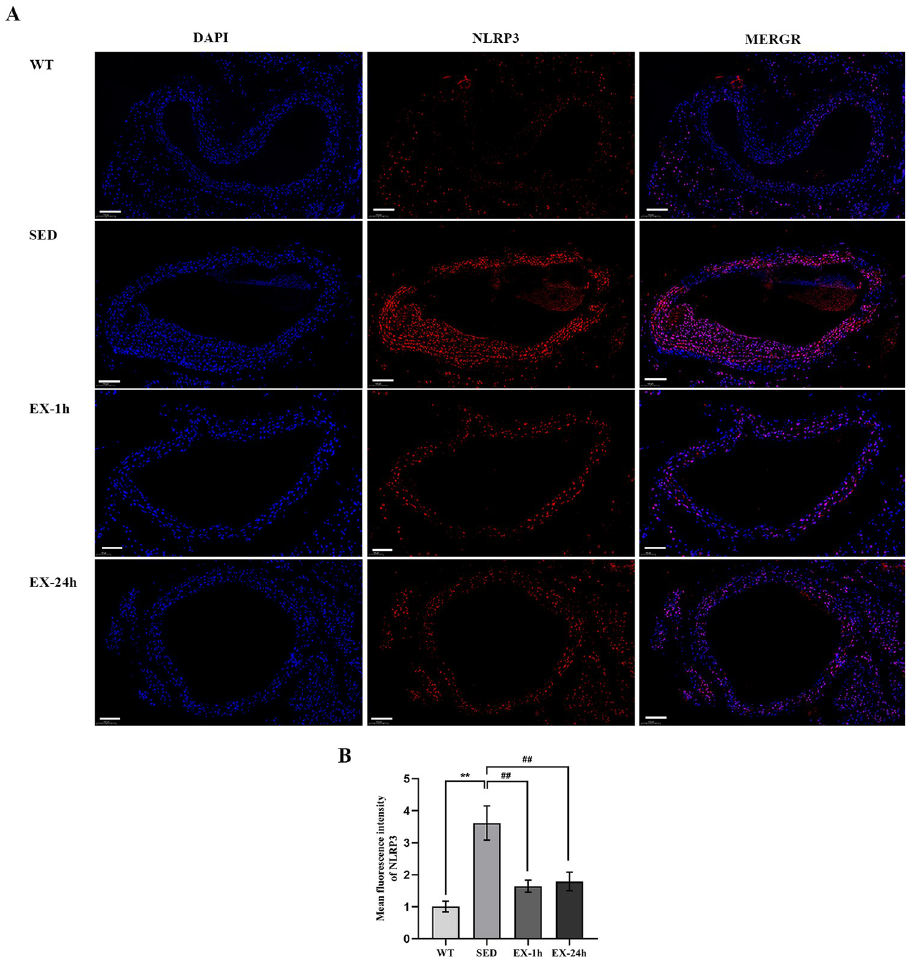
Fig 9. Aerobic exercise inhibits the expression of NLRP3 protein in the aorta. ( A ) The expression of NLRP3 protein in the aorta was detected by the immunofluorescence method. Scale bar = 100 μ m. ( B ) Analysis of the average fluorescence intensity of NLRP3 in the aorta (n = 5, three slices taken from each mouse for staining). The data are expressed as mean ± SD. �� p < 0.01 vs. WT group; ## p < 0.01 vs. SED group.